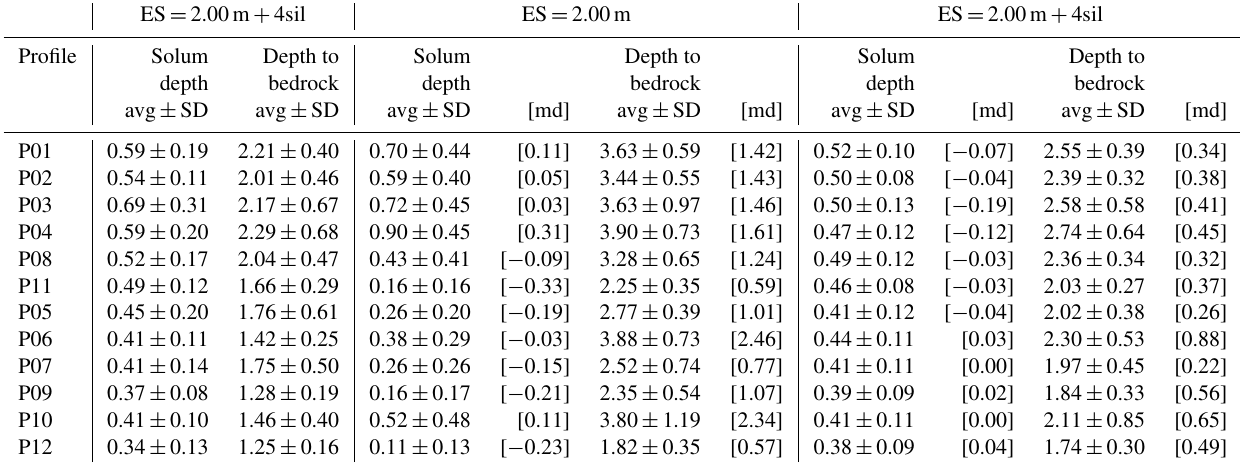
Table 3. Interface depths (avg ± SD, average ± standard deviation in metres) derived from the inversion results obtained for the 12 plot-scale ERT profiles measured in the Weierbach catchment using an ES of 0.5 or 2m (upgraded or not with the four interpolated levels of surficial apparent resistivity; sil stands for surficial interpolated levels). Mean differences (md) in interface depths with the reference ERT images relying on an ES of 0.5m were added to the standard and upgraded results obtained with an ES of 2m. ES = 2.00m +